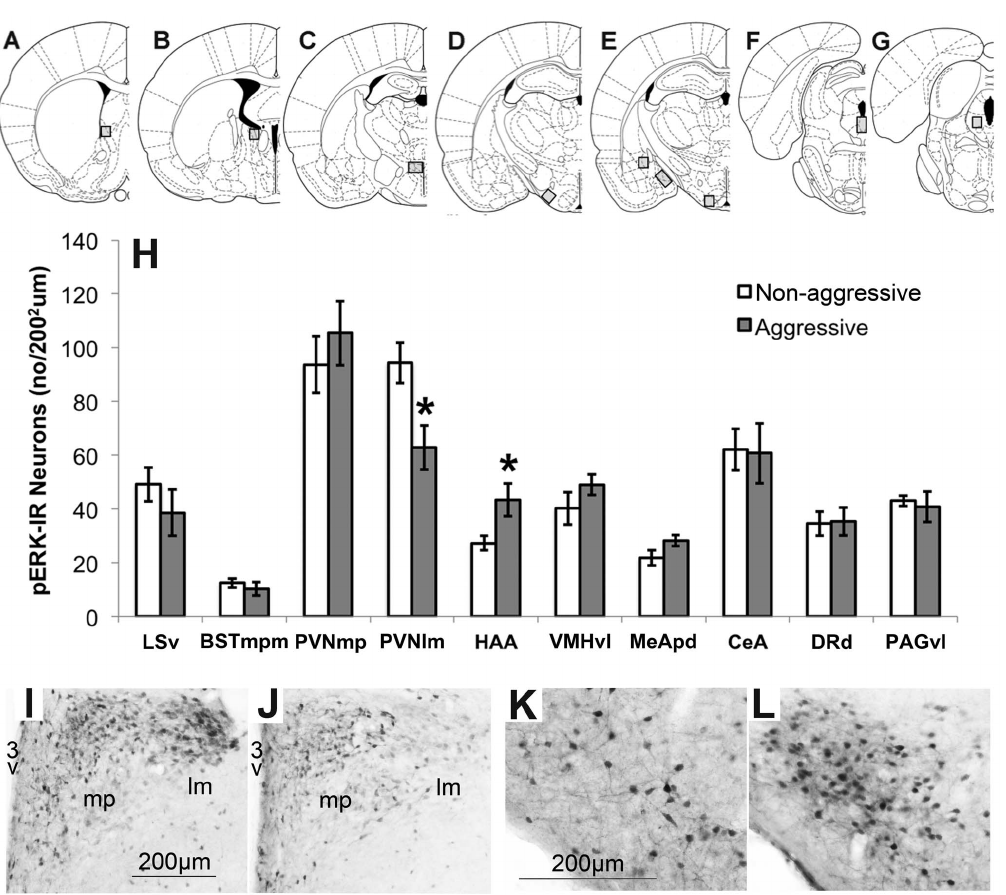
Figure 5. Immunohistochemical single-labeling of pERK. A–G: schematic drawings of coronal brain sections (derived from the Paxinos rat brain atlas, 63) with grey squares corresponding to the location of the quantified brain areas ( A: LSv, bregma + 0.20; B: BSTmpm , bregma 2 0.80; C : PVNm and PVNl, bregma 2 1.80; D: HAA, bregma 2 2.80; E: MeApd, CeA, VHMvl , bregma 2 3.14; F: DRd, bregma 2 7.80; G: PAGvl, bregma 2 8.30); H: Average density of pERK-IR in non-aggressive (white bars, n=7) compared with aggressive (grey bars, n=7) adolescent (7–8 week old) female NAB rats. Data are means 6 s.e.m; *P , 0.05; I–J: Illustration of pERK-IR in the PVNmp (‘‘mp’’) and PVNlm (‘‘lm’’) of non-aggressive (left) and aggressive (right) individuals (3v=third ventricle); K–L: Illustration of pERK-IR in the HAA of non-aggressive (left) and aggressive (right)